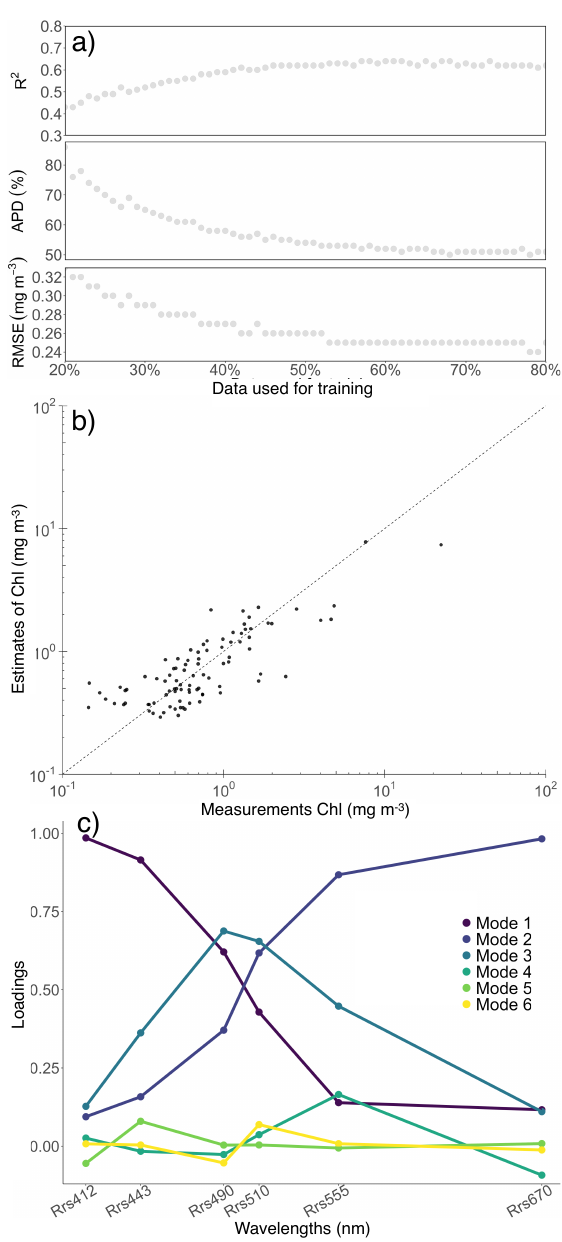
Figure 4. Features of the EOF method: ( a ) stability of the EOF; ( b ) scatter plot of in situ Chl versus satellite-derived Chl using the EOF, with the dashed line as the 1:1 ratio; ( c ) all modes of oscillation (solid coloured lines are linear interpolation over wavelengths of the discrete spectral data and are used as a guide to aid visualizing the spectral